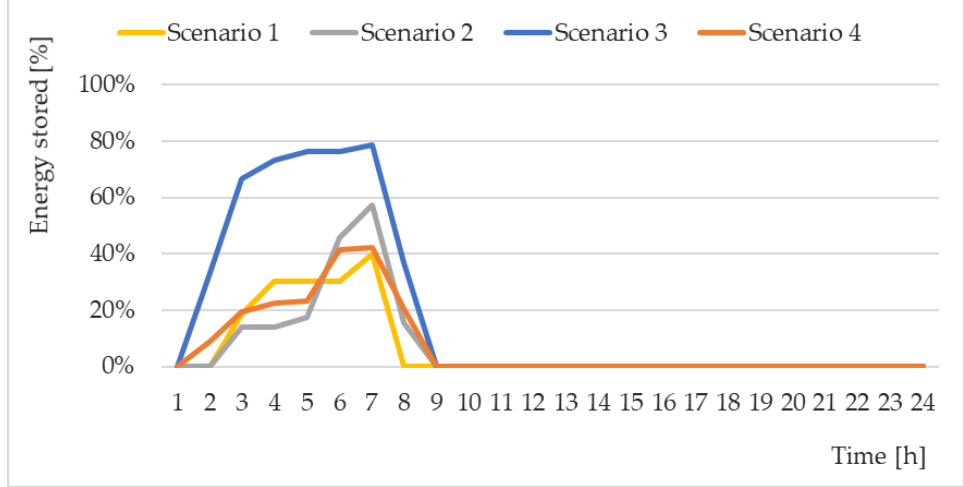
Figure 8. Results—energy stored in the energy storage (ES) depending on the simulation scenario.